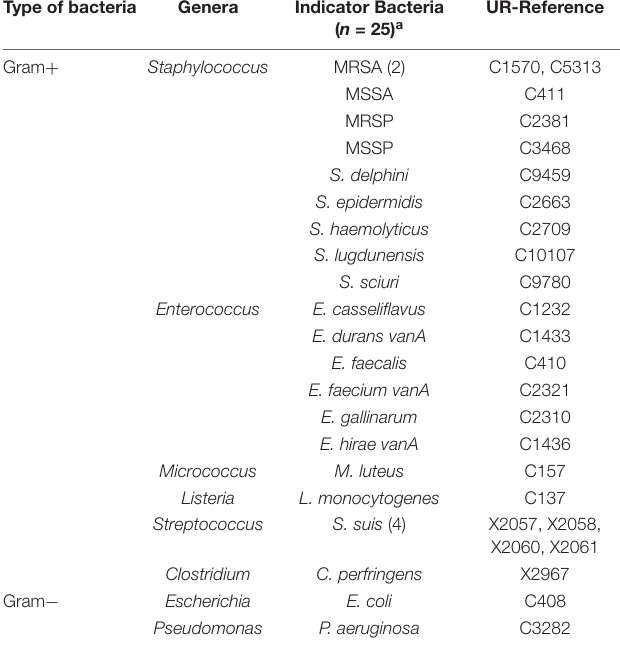
TABLE 2 | Indicator bacteria used in the antimicrobial test, differentiated in terms of genera and